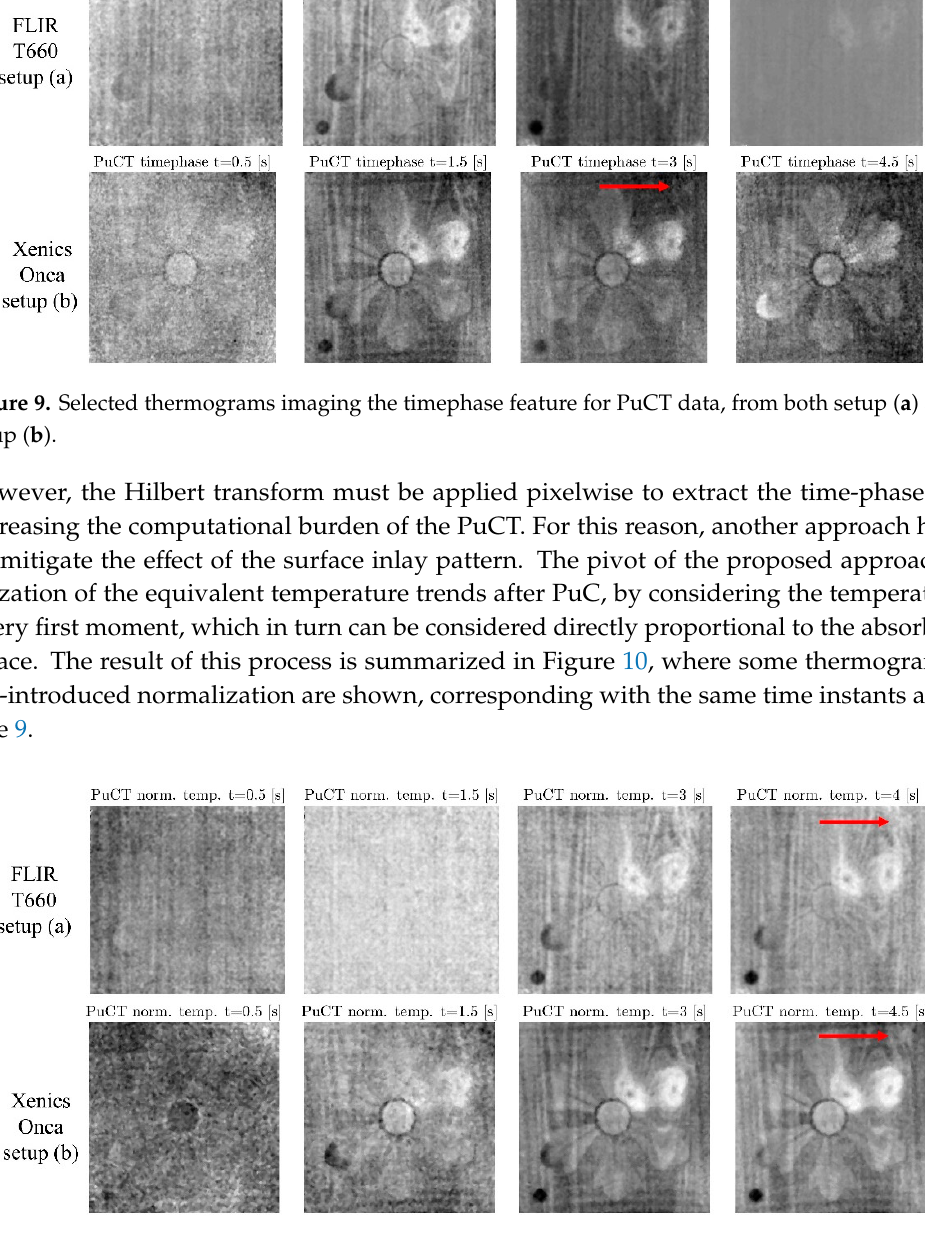
Figure 10. Selected thermograms imaging the normalized temperature for PuCT data, from both setup (a) and setup (b).